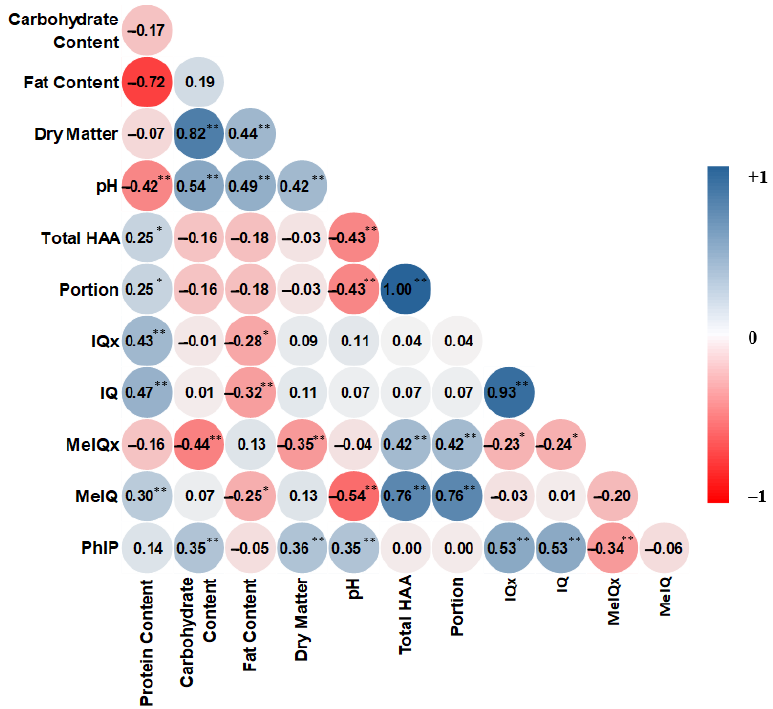
Figure 1. Pearson’s correlation coefficient among different chemical and physiochemical properties of UHT milks. (**: p < 0.01; *: p < 0.05).